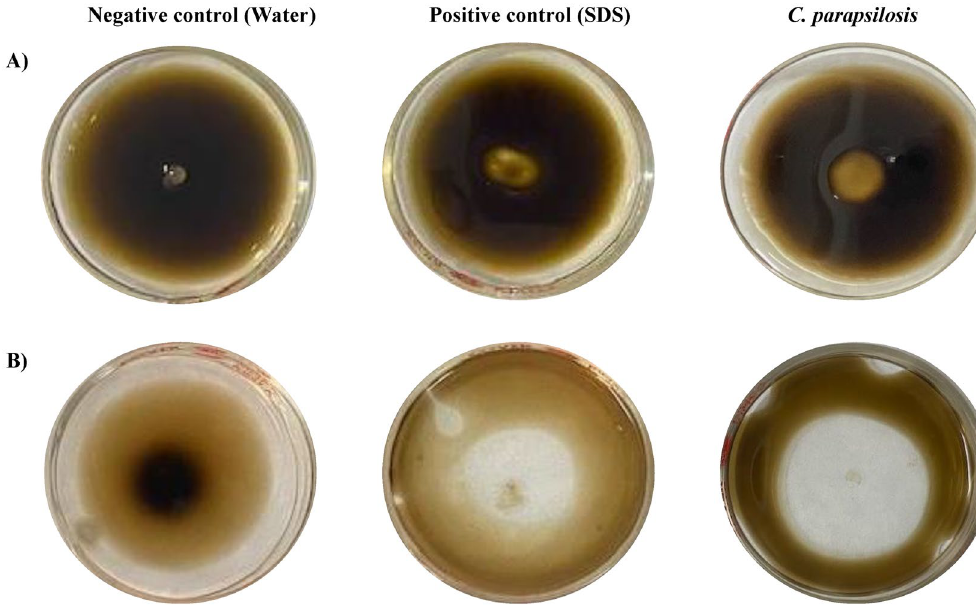
Figure 4. Oil spreading assay of C. parapsilosis . An amount of 20 ml of water was added to the Petri plate (100 mm) followed by 20 µl of either crude oil ( A ) or mixed oil ( B ), which formed a thin layer on the surface of the water. Then, 10 µl of either water, 1% SDS, or CFSs of C. parapsilosis were added to the surface and the spreading of the oil was noticed.